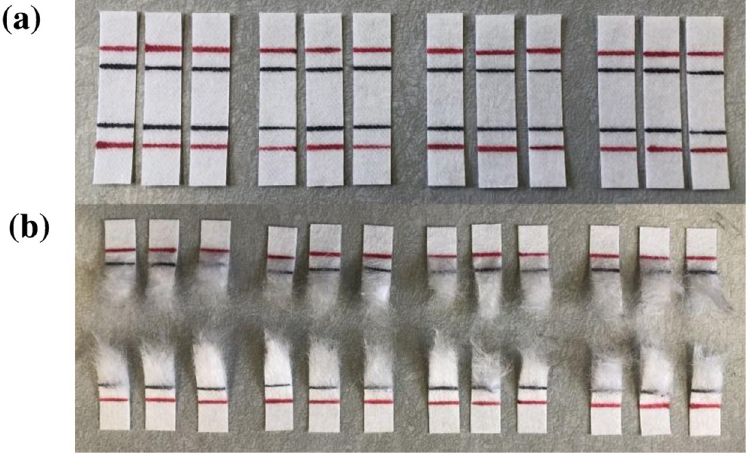
Fig 8. Ozone treated polypropylene samples (raw material) before (a) and after (b) breaking in the tensile